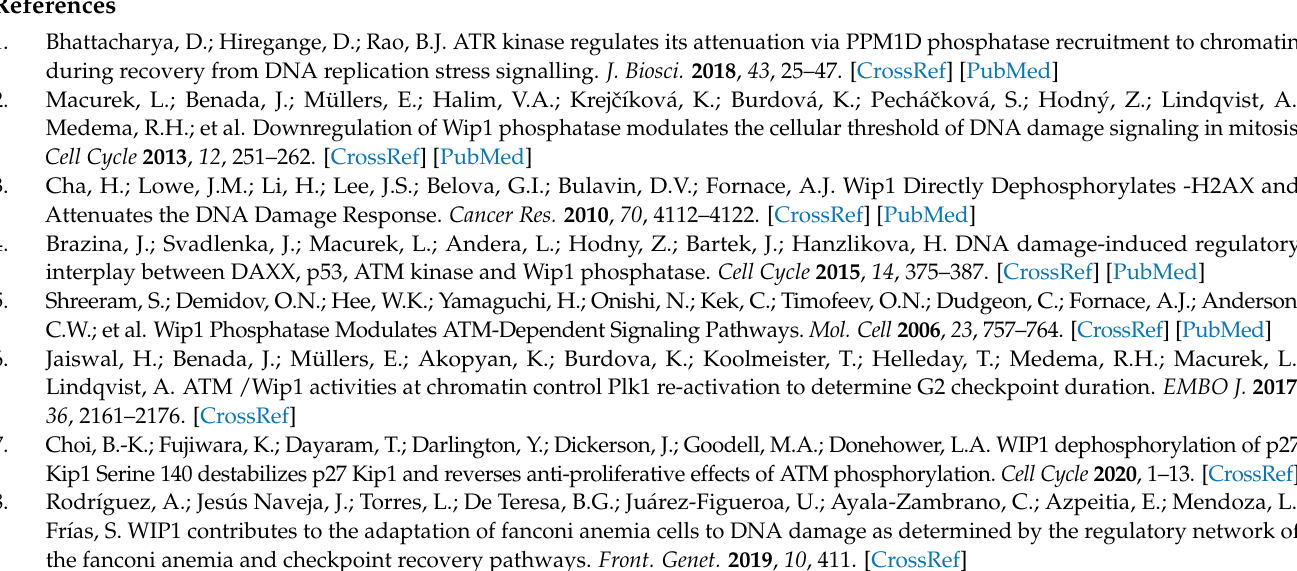
Table S5: Top 20 upregulated (red) and downregulated (blue) genes in MV-4-11 cells treated with Nut3a+WIP1i vs. WIP1i, Table S6: Top 20 upregulated (red) and downregulated (blue) genes in NOMO-1 cells treated with Nut3a+WIP1i vs. WIP1i, Table S7: Top 20 upregulated (red) and downregulated (blue) genes in MV-4-11 cells treated with Nut3a+WIP1i vs. Nut-3a, Table S8: Top 20 upregulated (red) and downregulated (blue) genes in NOMO-1 cells treated with Nut3a+WIP1i vs. Nut-3a, Table S9: P53 target and signature genes that are significantly upregulated in MV-4-11 or NOMO-1 cells treated with Nut-3a+WIP1i vs. control; Figure S1: WIP1 protein expression in AML cell lines, Figure S2: Additional transcriptional signatures in single and combined-treatment enriched in MV-4-11 and NOMO-1 cells, Figure S3 Expression changes of p53 and its related genes induced by the treatment in TP53 -wt and TP53 -mut